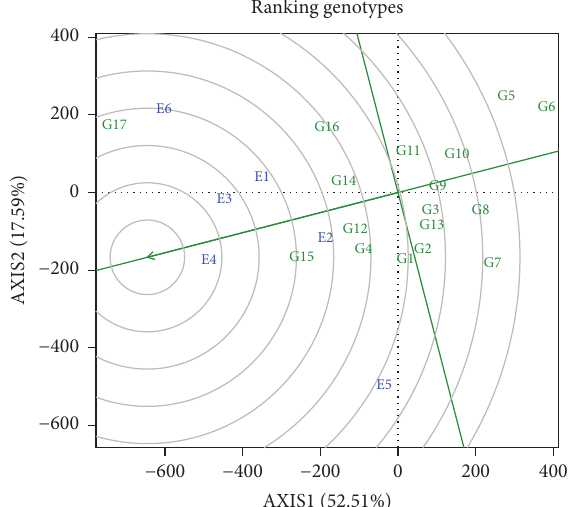
Figure 4: GGE biplot based on genotype-focused scaling for comparison and genotypes with the ideal genotype. Note: